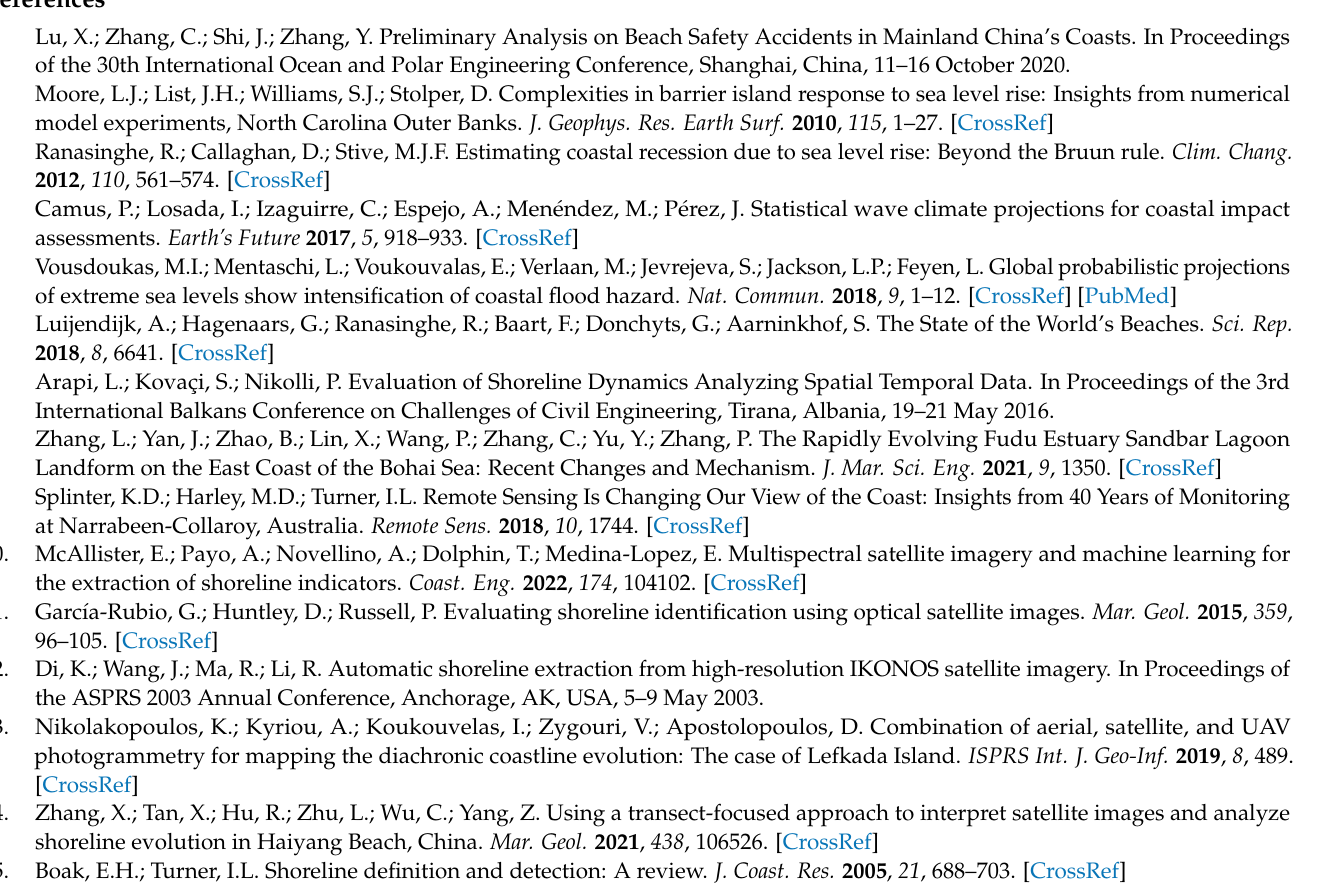
Figure A2. Spatial distribution maps of particle size parameters. ( a ) The median particle size of surface sediments (Md); ( b ) sorting coefficient of surface sediments (St); ( c ) skewness coefficient of surface sediments (Sk). Table A1. Grain size parameters of beach sediment samples.